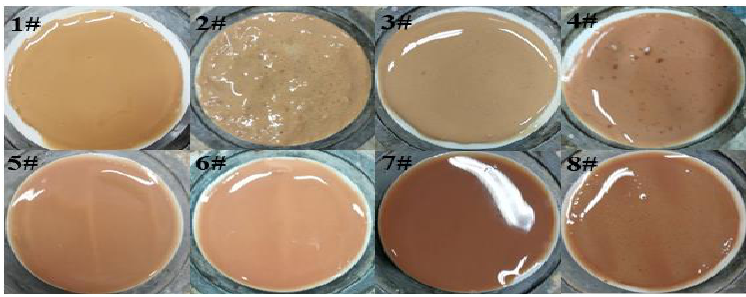
Figure 9. The mud cakes produced by different types of drilling fluids.